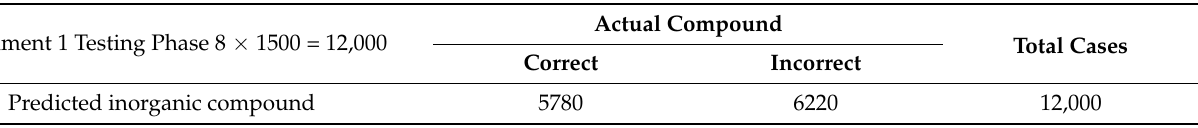
Table 7. Experiment 1 confusion matrix for the proposed CNN without the transfer learning using DS1 eightfold testing and (Map EE ) as input for training.